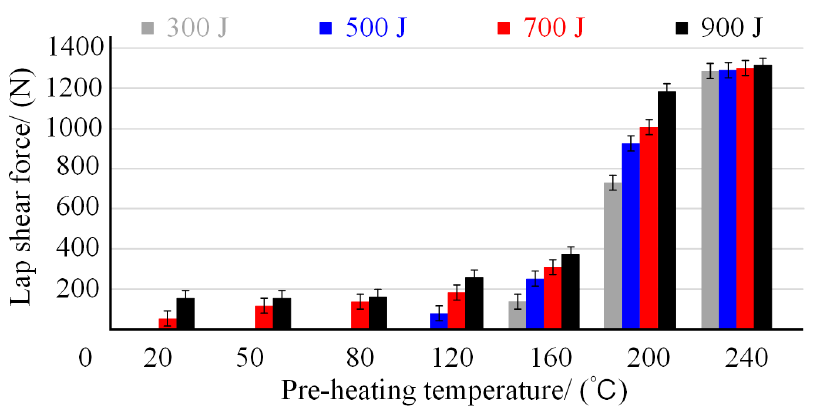
Figure 16. Ultimate lap shear strength of the joints under different joining parameters.